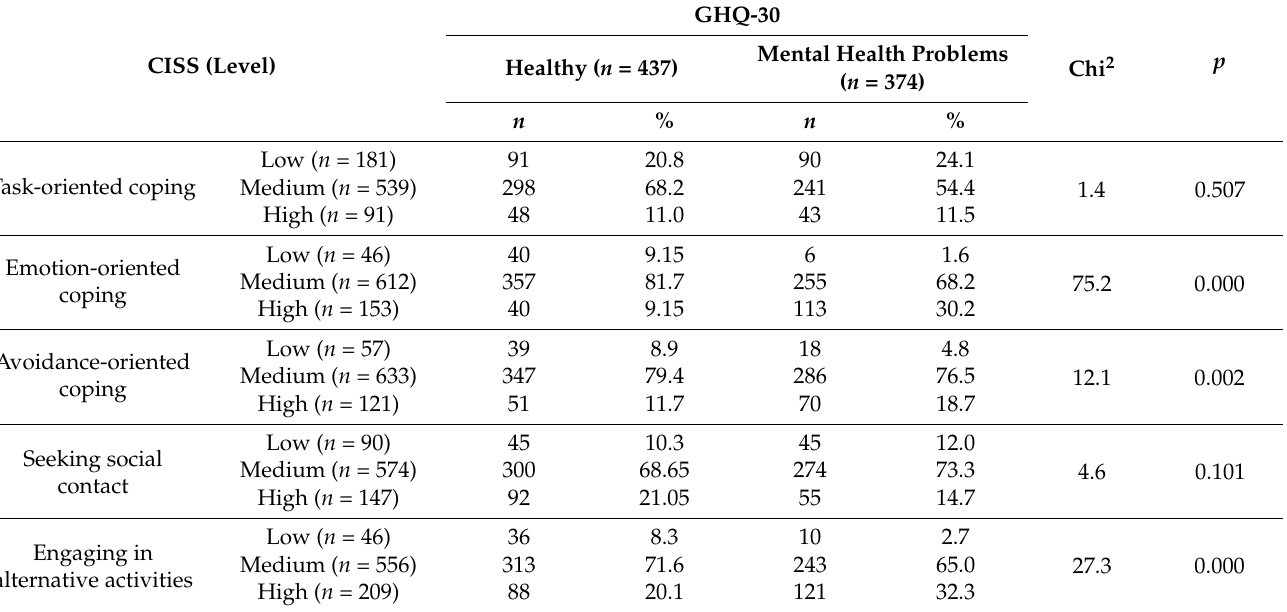
Table 4. The relationship between the mental state according to the GHQ-30 Questionnaire and the styles of coping with stress according to the CISS